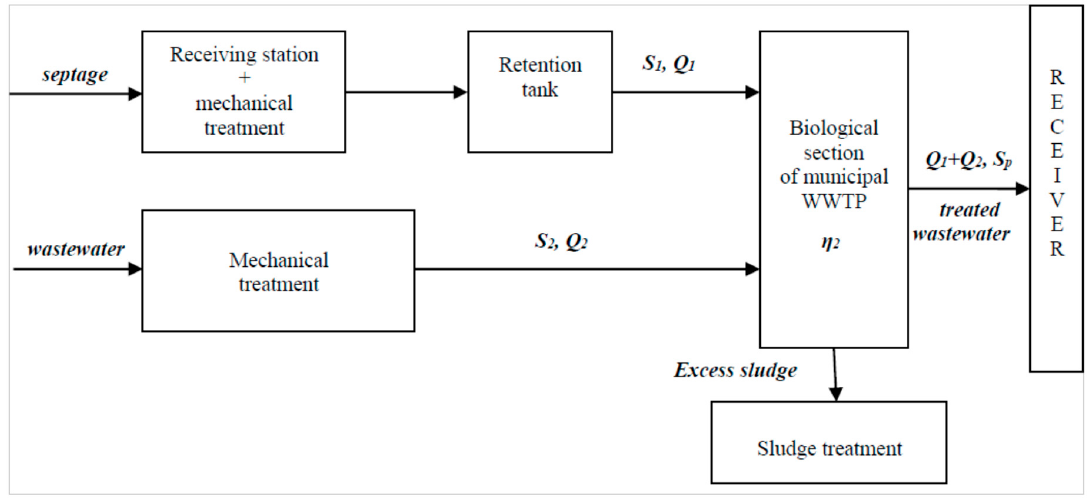
Figure 2. Block diagram of the variant zero of wastewater and septage treatment.